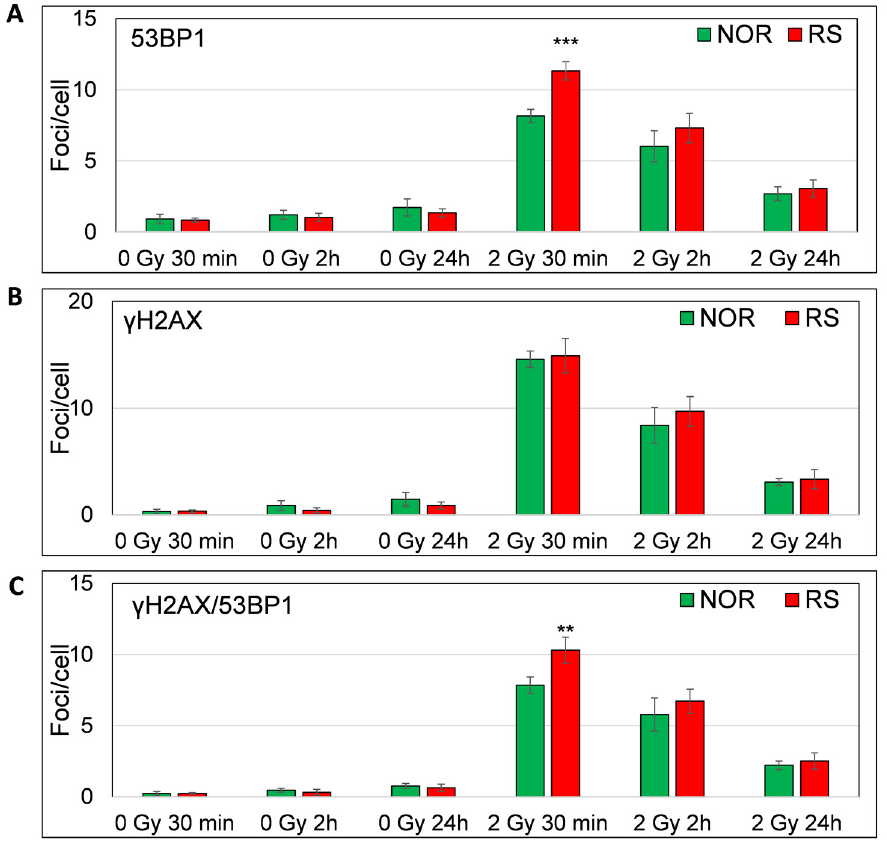
Figure 7. In vitro assessment of γ H2AX /53BP1 DNA repair foci. Figure shows the level of 53BP1 ( A ), γ H2AX ( B ) and co-localized γ H2AX/53BP1 ( C ) foci 30 min, 2 h and 24 h after irradiation with 0 and 2 Gy of γ -rays. Mean values from four RS and four matched NOR patients (No. 24, 26, 30 and 40 from Table S1) are shown. p -values are indicated by asterisk (** p ≤ 0.01; *** p ≤ 0.001).